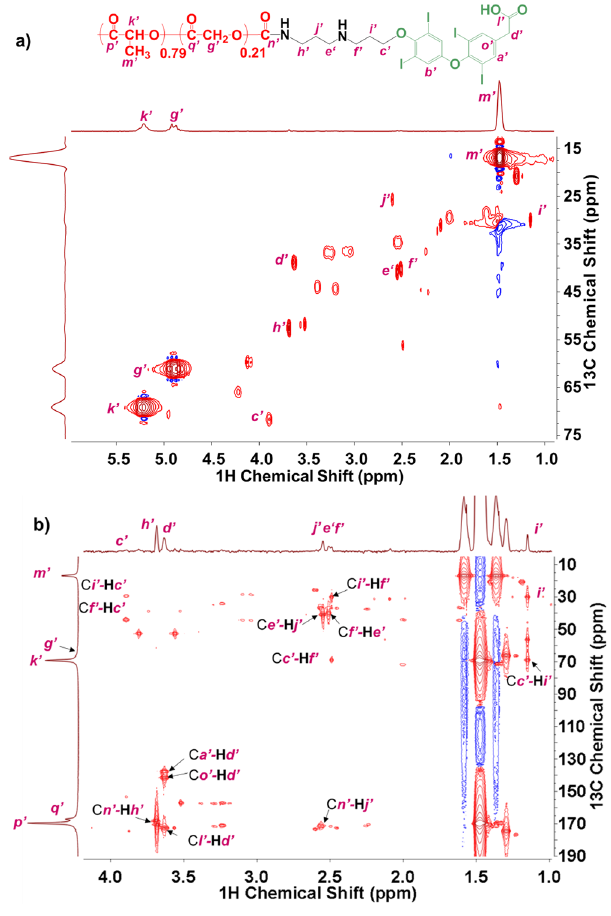
Figure 2. ( a ) 1 H- 13 C HSQC/HSQC-DEPT 2D NMR and ( b ) 1 H- 13 C HMBC 2D NMR of PLGA-DAT in